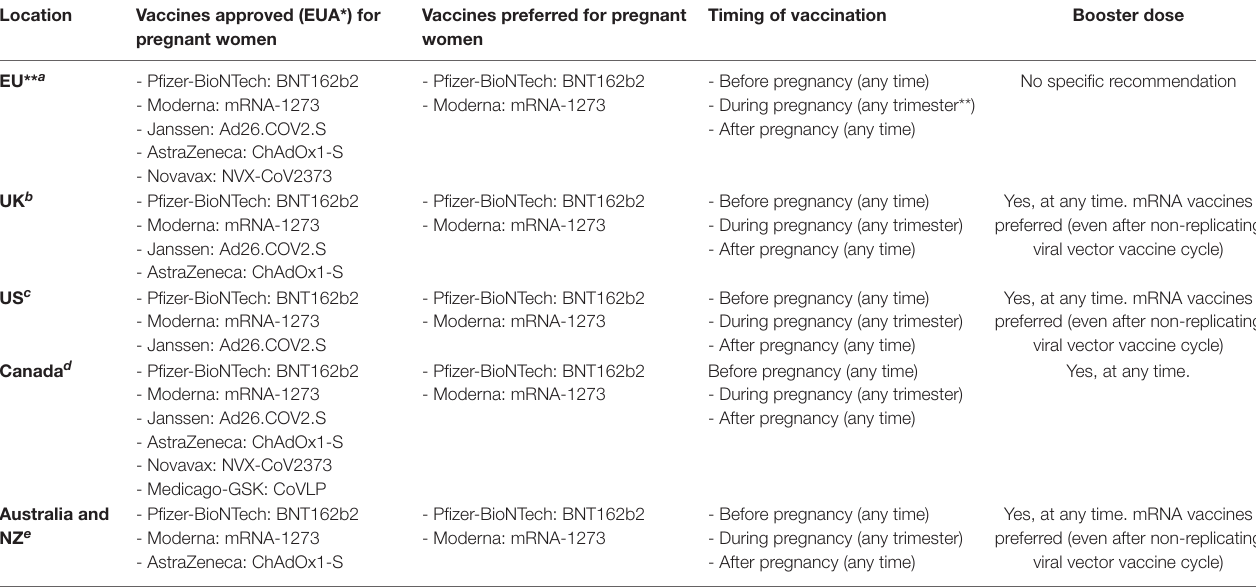
TABLE 1 | National and supranational selected recommendations regarding coronavirus disease 2019 (COVID-19) vaccination during pregnancy and breastfeeding. Location Vaccines approved (EUA*) for Vaccines preferred for pregnant Timing of vaccination Booster pregnant women women